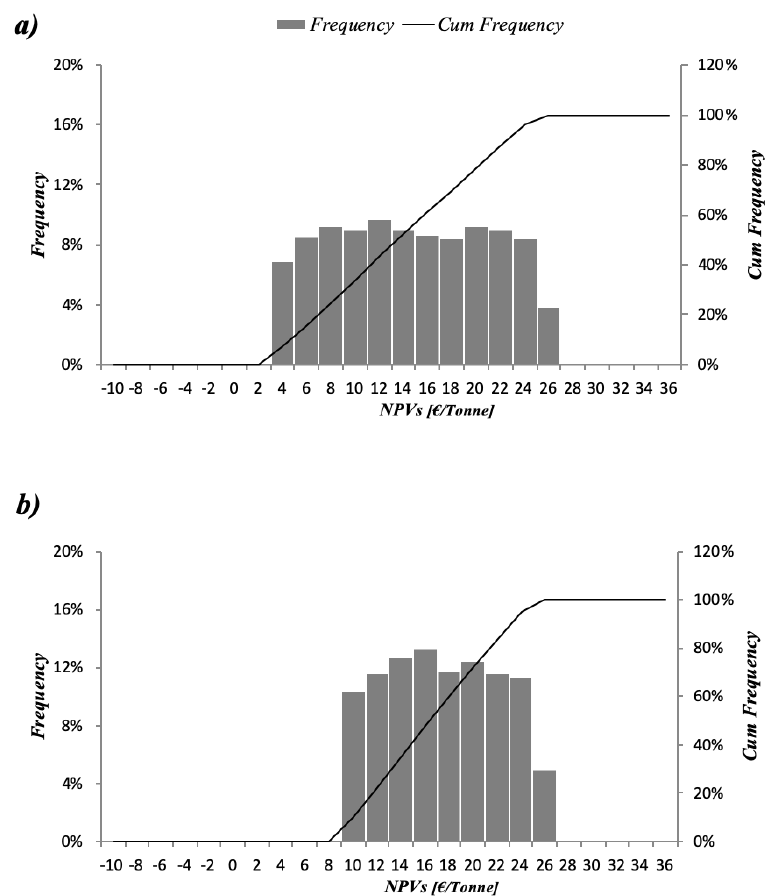
Figure 2. NPV s density and distribution function. ( a ) Scenario 2, renewable electricity production; ( b ) Scenario 3, biomethane production.